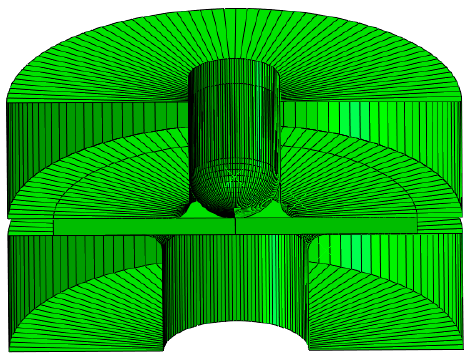
Figure 4. FEM set up of the SPT.